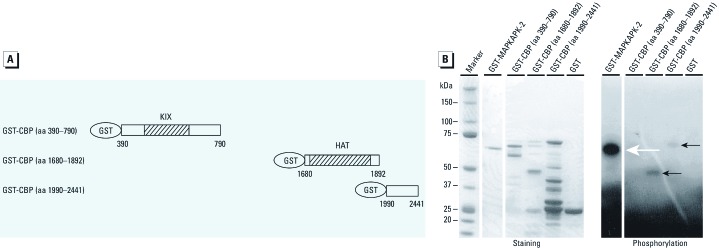
Activated p38α phosphorylates CBP in vitro. (A) Schematic of GST fusion proteins used for the in vitro kinase assays; aa, amino acids. (B) GST fusion proteins were purified and standardized according to protein concentration. Purified activated p38α was used to phosphorylate GST-CBP fragments in the presence of 32P-ATP followed by SDS‑PAGE and coomassie staining (left). Gels were dried and autoradiographed (right). GST-MAPKAPK2 was used as a positive control for p38α phosphorylation. The white arrow indicates phosphorylated GST-MAPKAPK2, and black arrows indicate phosphorylated GST-CBP fragments. Similar results were obtained in three independent experiments.